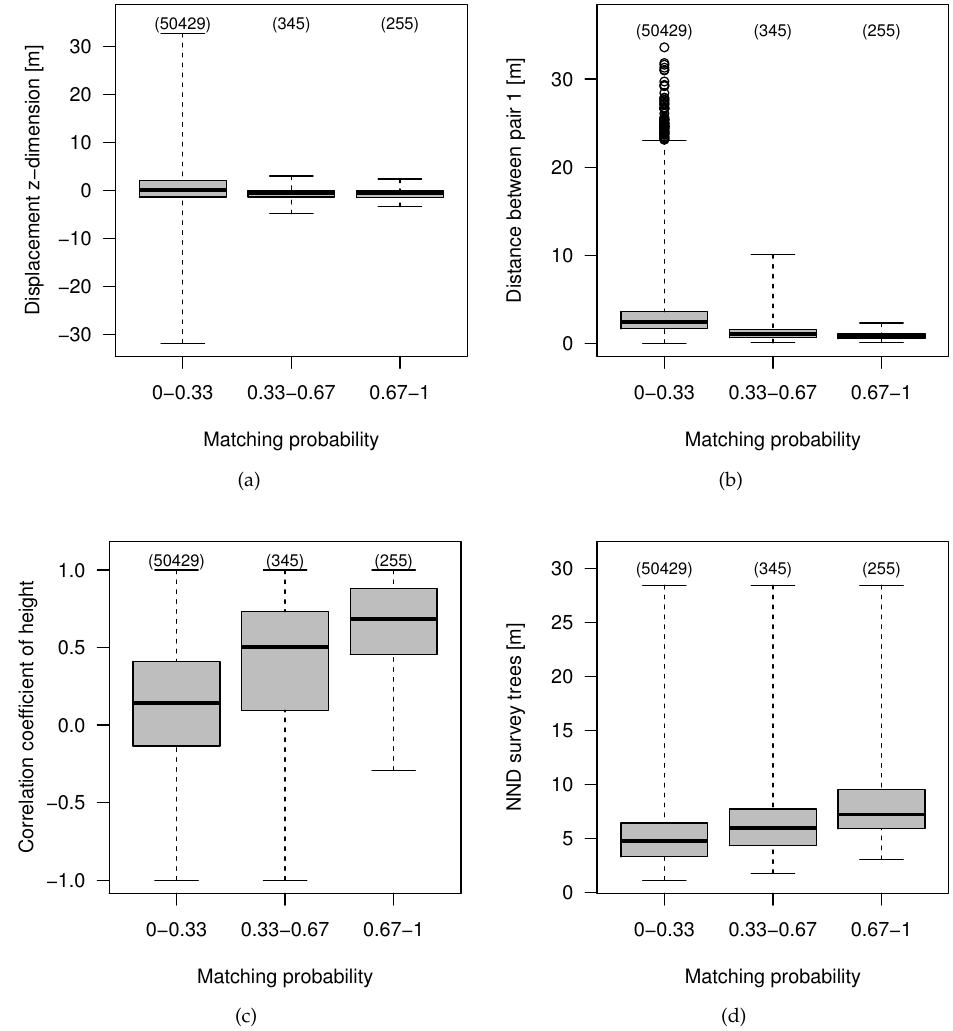
Figure 6. Effect of ( a ) the vertical displacement of the plot center; ( b ) the distance between the first point pair; ( c ) the correlation coefficient for tree height; and ( d ) the NND for surveyed trees on the matching probability (using just one simulation for each plot). The numbers in brackets correspond to the number of tree pairs. The whiskers extend to ten times the interquartile range. Outliers are marked by